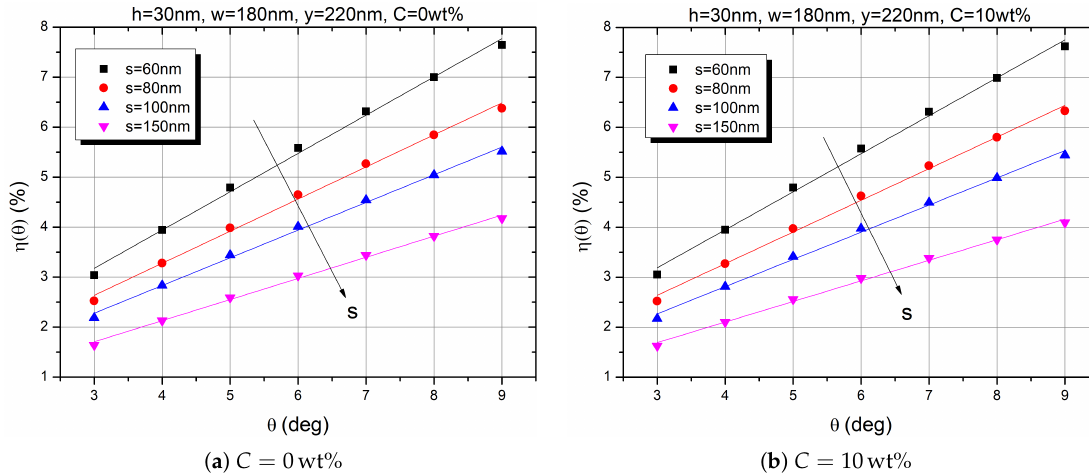
Figure 6. Percentual shift in effective refractive index η ( θ ) over the tilt angle θ of both concentrations, with slot width s as